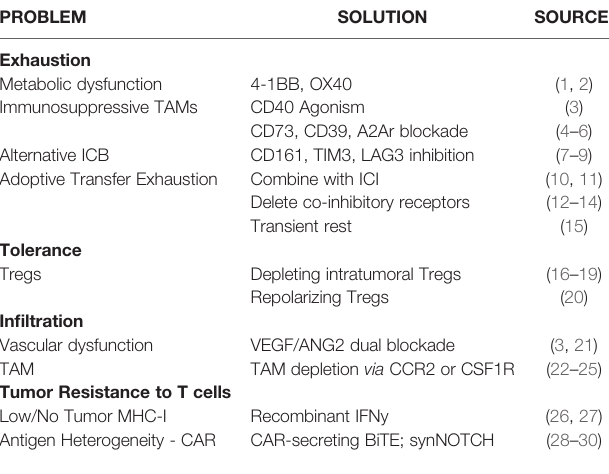
TABLE 1 | Emerging therapies to overcome barriers to T cell function.